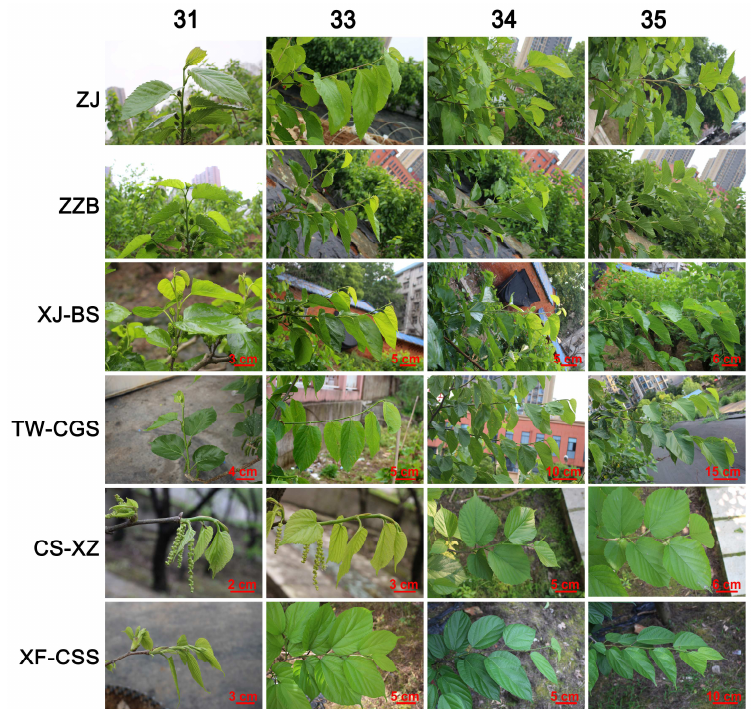
Figure 3. Stages of shoot development for mulberry according to the BBCH scale.